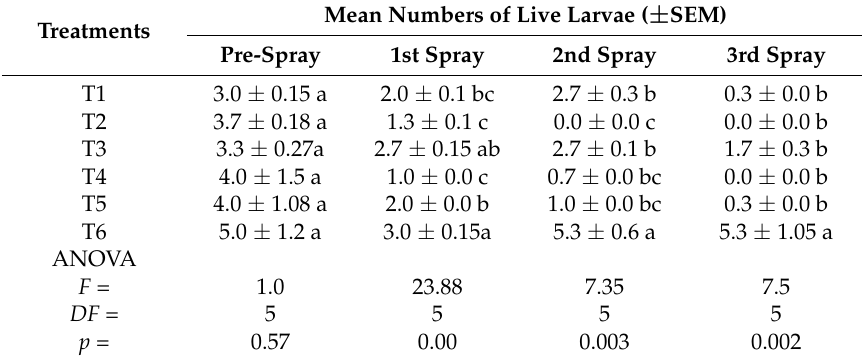
Table 8. Mean number ( ± SEM) of FAW larvae after treatment application. Mean Numbers of Live Larvae ( ± Treatments